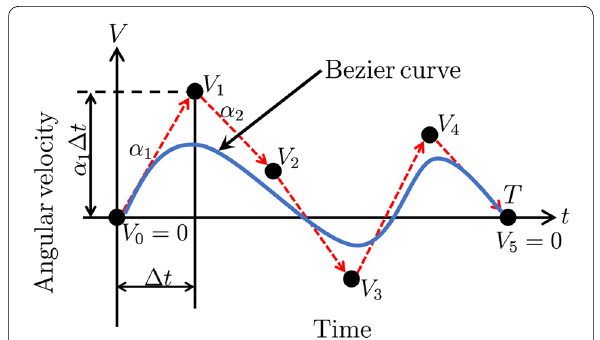
Fig. 3 How to generate joint velocity curve